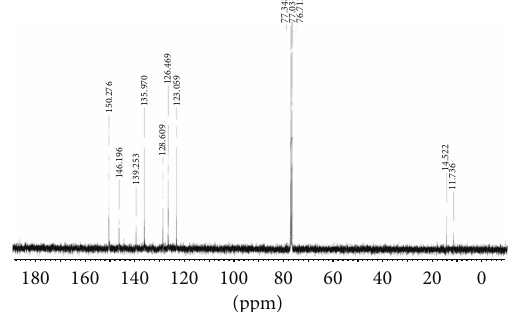
Figure 1: FT-IR spectrum of [Ru(L 1 ) 2 (NCS) 2 ] complex in KBr.